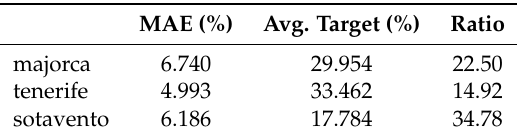
Table 7. Comparison of the percentage MAEs with the average energy produced as a percentage of installed